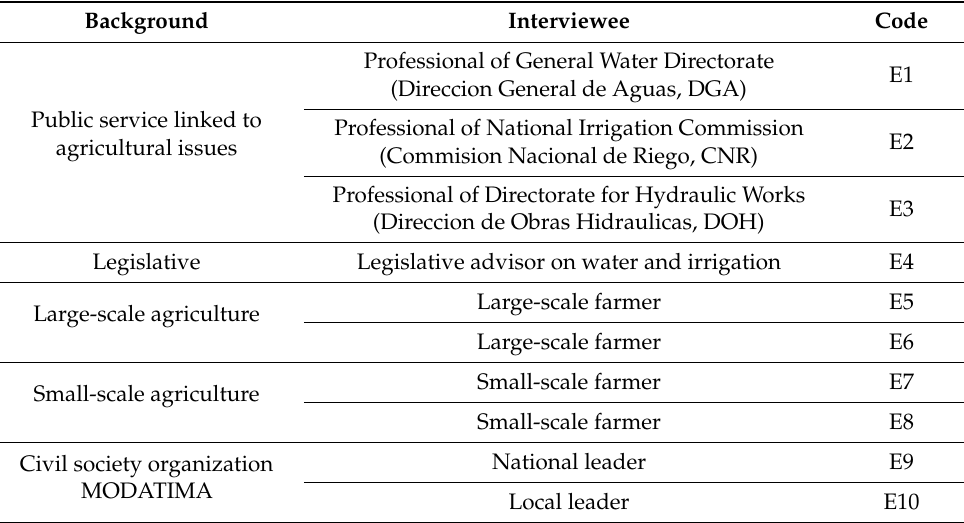
Table 2. Interview